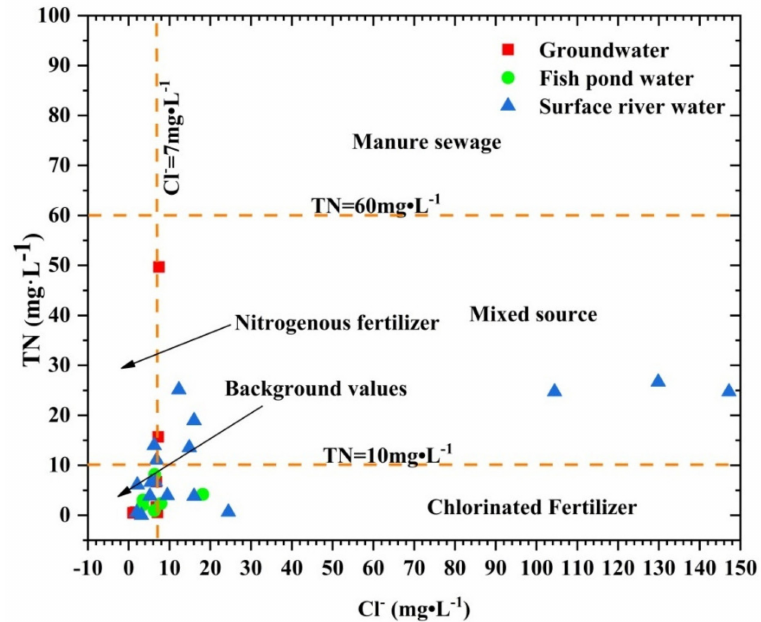
Figure 5. Relationship between CI- and TN in three kinds of water bodies in the study